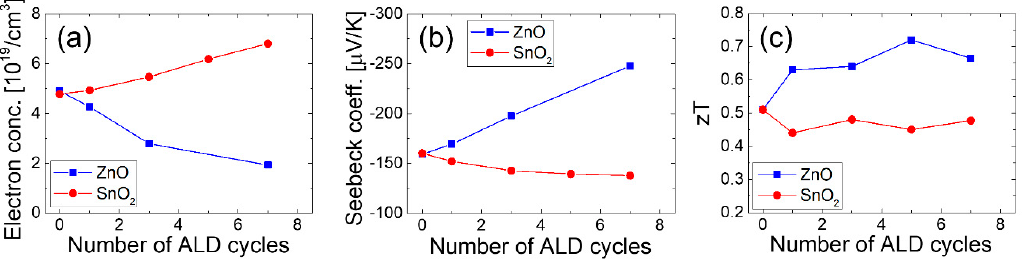
Figure 3. Variations in the ( a ) electron concentration; ( b ) Seebeck coefficient; ( c ) zT of the ALD-coated Bi 2 Te 2.7 Se 0.3 as a function of the number of ALD cycles.